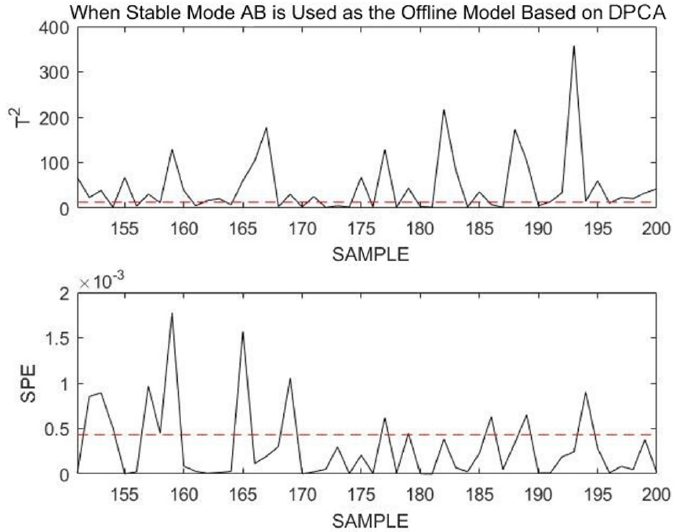
Figure 20. Monitoring 151st to 180th sample points using transition mode AB as an offline model Base on DPCA.